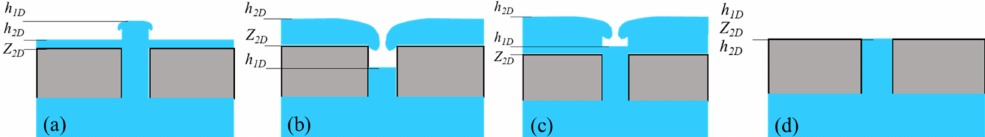
Figure 4. Schematic diagram of water exchange between one-dimensional pipeline and two-dimensional surface. ( a ) h 2D < h 1D ; ( b ) h 1D < Z 2D < h 2D ; ( c ) Z 2D < h 1D < h 2D ; ( d ) Z 2D = h 1D = h 2D